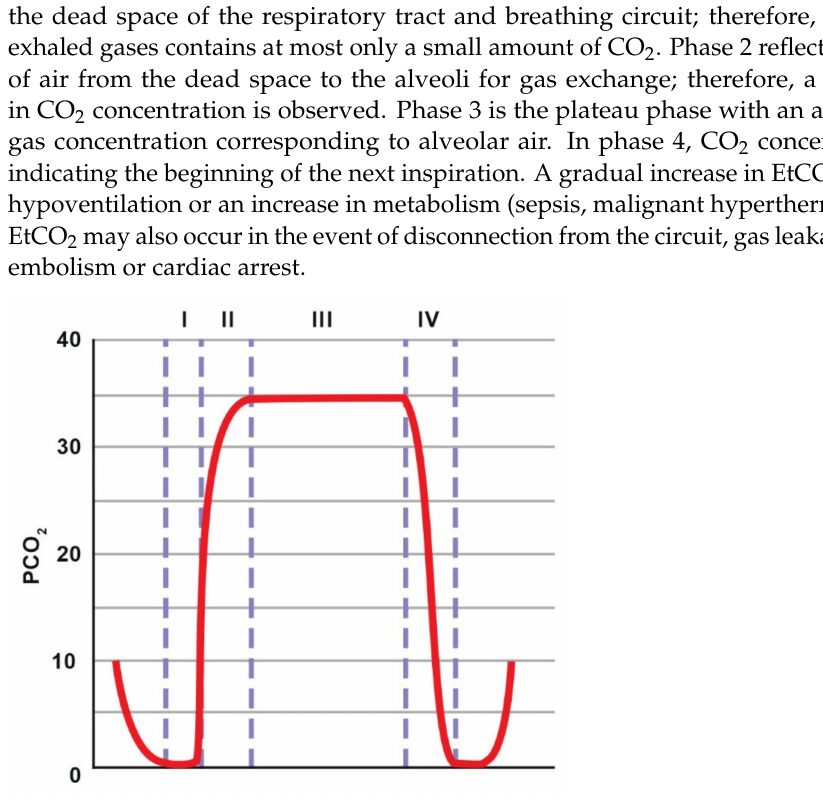
Figure 7. Normal capnogram. The description is included in the text. Adapted with permission from [91] Copyright 2013